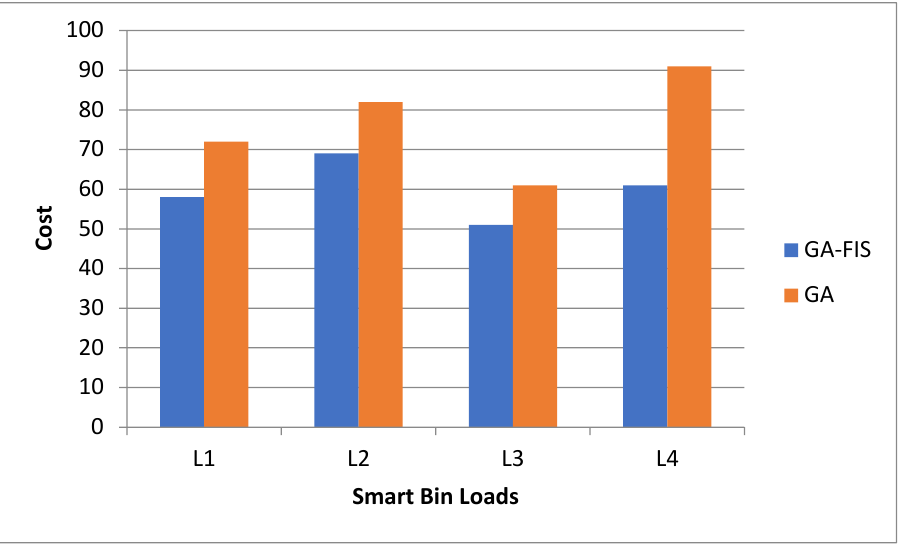
Figure 20. Performance analysis of GA-FIS with GA.